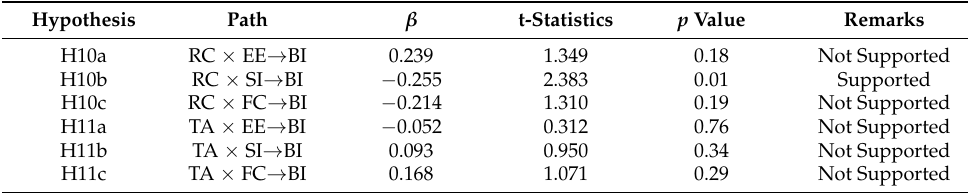
Table 6. Bootstrapping results for the moderating